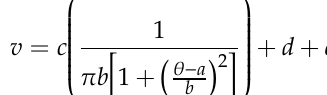
Table 3. Adaptation of the WFDSS estimated travel rates, where absolute travel rates are converted to